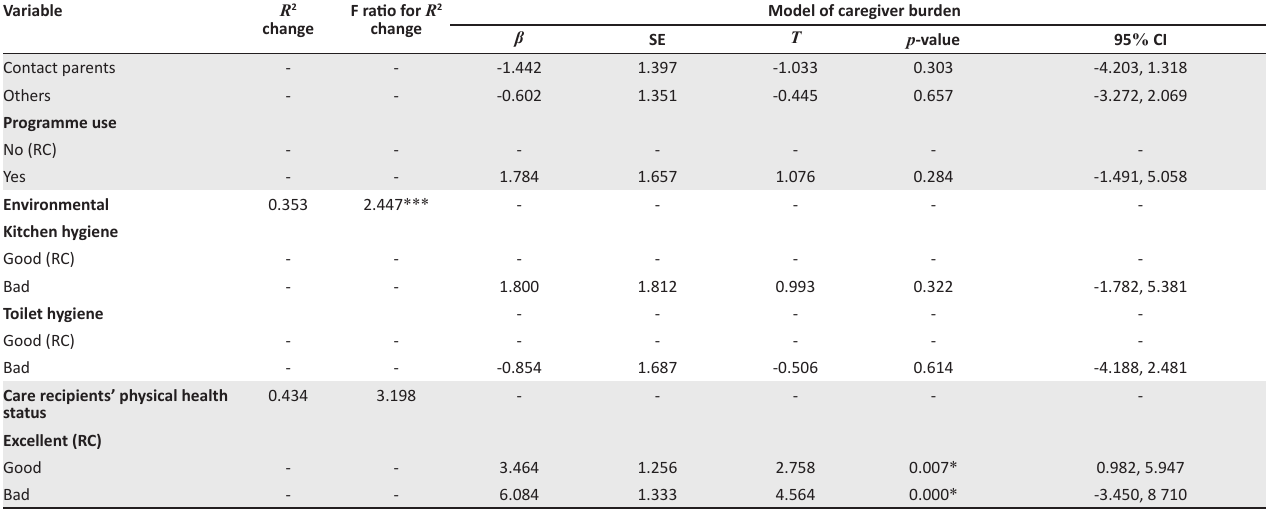
TABLE 2 (Continues...): Results of multiple regression analysis of mediators, environmental and physical health factors (Model 5). Variable